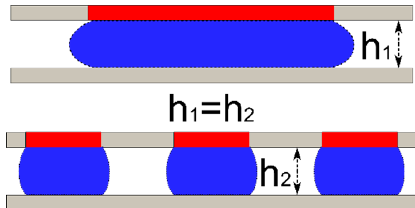
Figure 8. Case study 1: fixed gap height (1 mm) and fixed load (1078 µ N). The wetting areas (hydrophilic) are the shaded region. This case compares single vs. multiple droplets for bearing application.